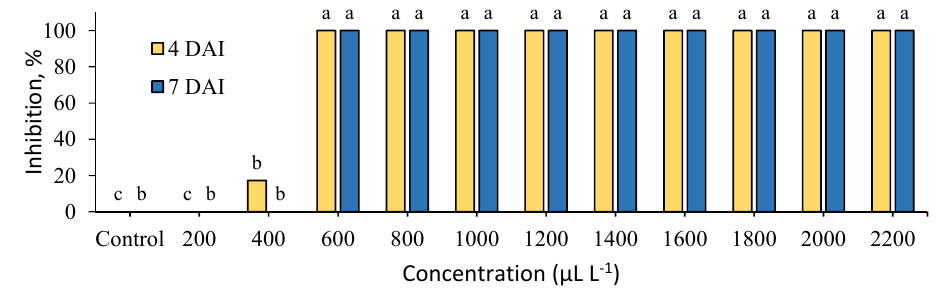
Figure 1. Inhibition (%) of Botrytis cinerea mycelial growth by cinnamon ( C. cassia ) extract at 4 and 7 days after inoculation (4 DAI and 7 DAI). Results are presented as means ( n = 4). The same letter indicates no significant differences between treatments ( p < 0.05).